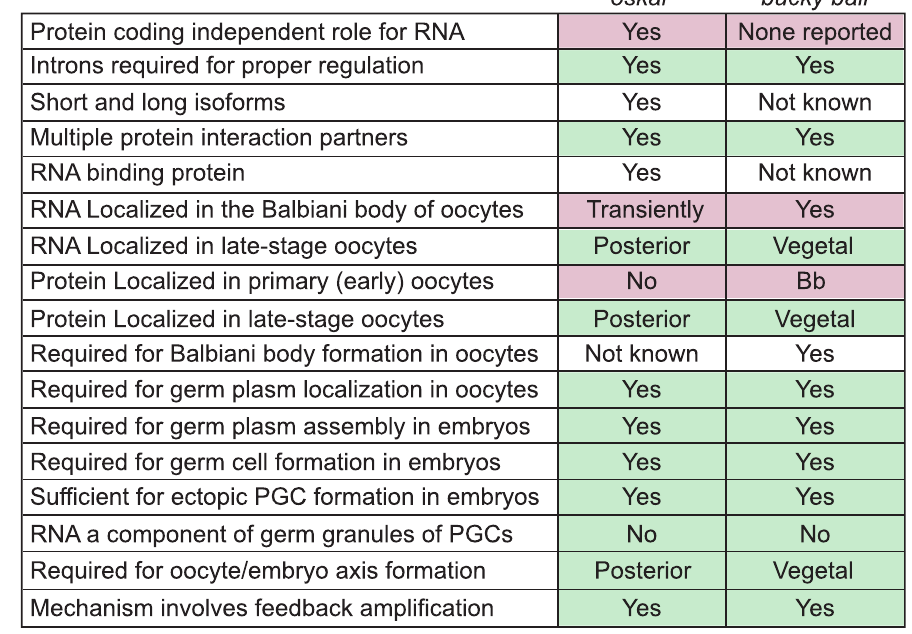
Figure 1. Comparison of two maternal germ plasm assemblers: oskar and bucky ball. The left column lists activities, localization, or other properties. Those attributed to Drosophila oskar or zebrafish bucky ball or both are indicated in the relevant columns. PGC, primordial germ